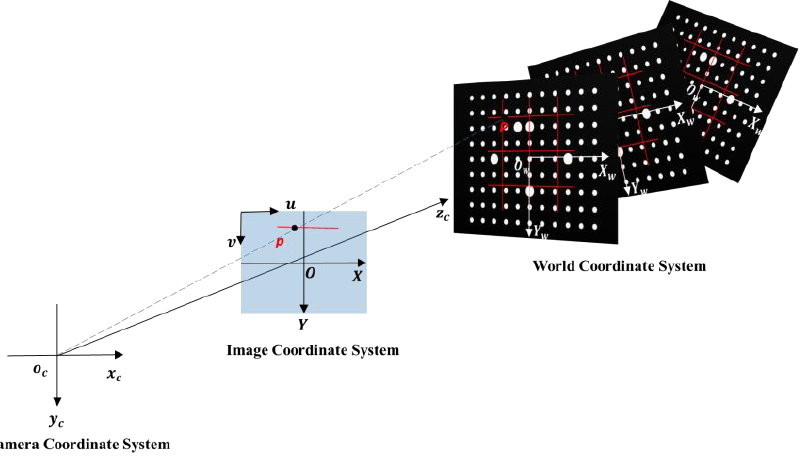
Figure 7. Schematic diagram of the system calibration.